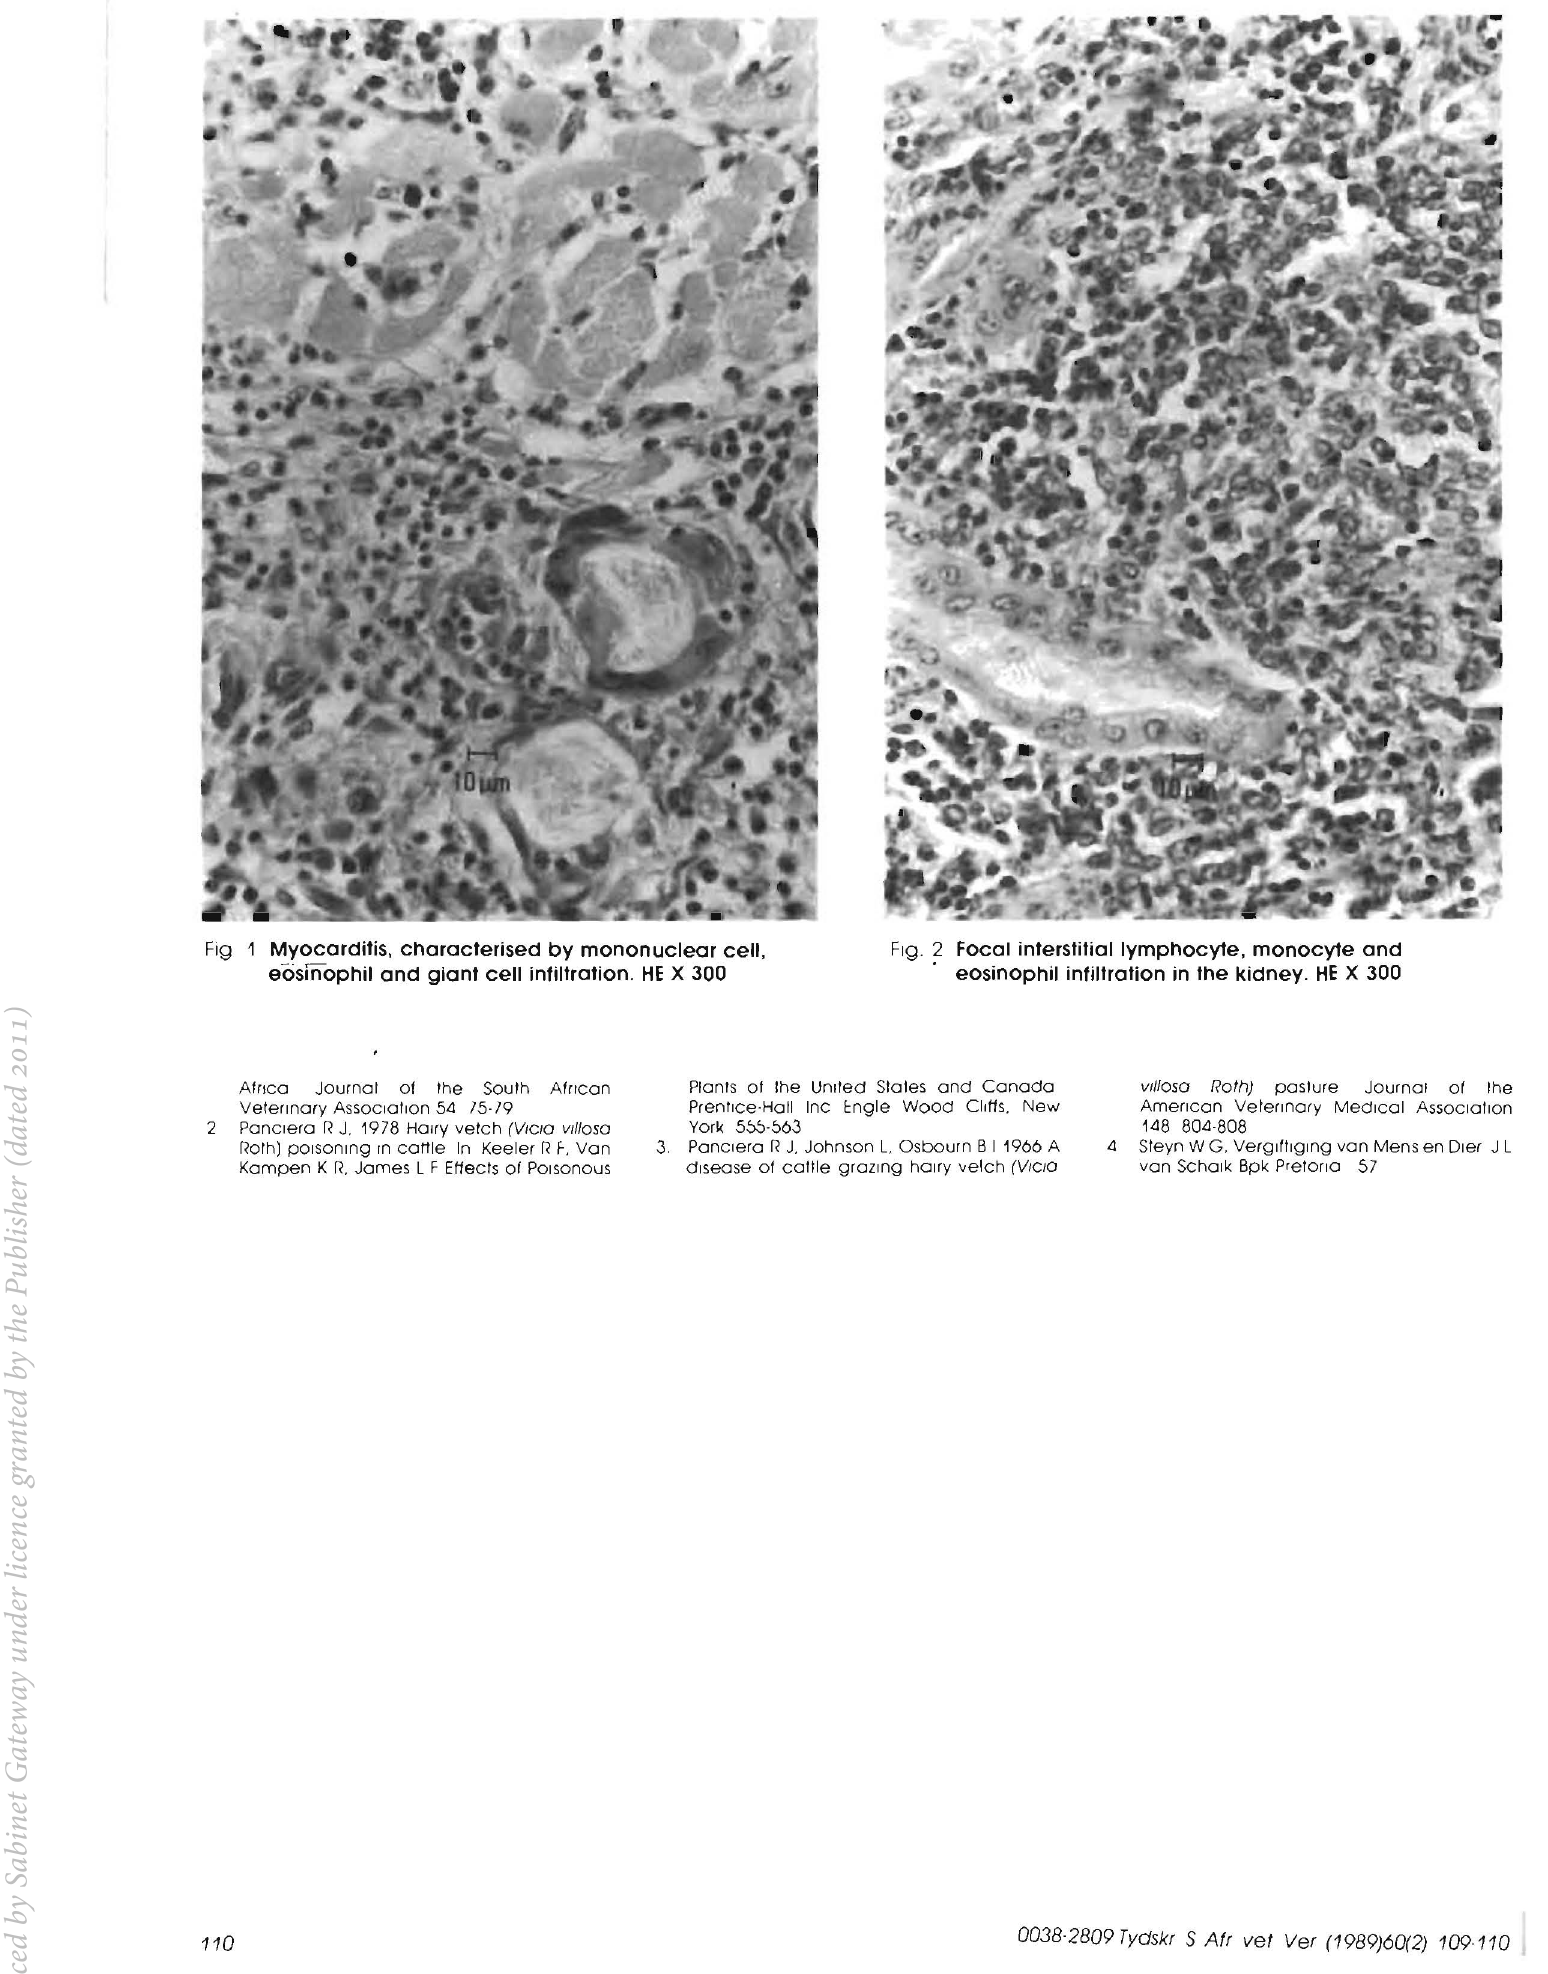
Fig 1 Myocarditis, characterised by mononuclear cell, eosinophil and giant cell infiltration. HE X 300